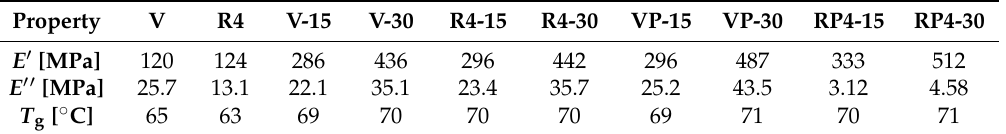
Table 6. DMTA results for all of the samples (abbreviations as in Table 5).